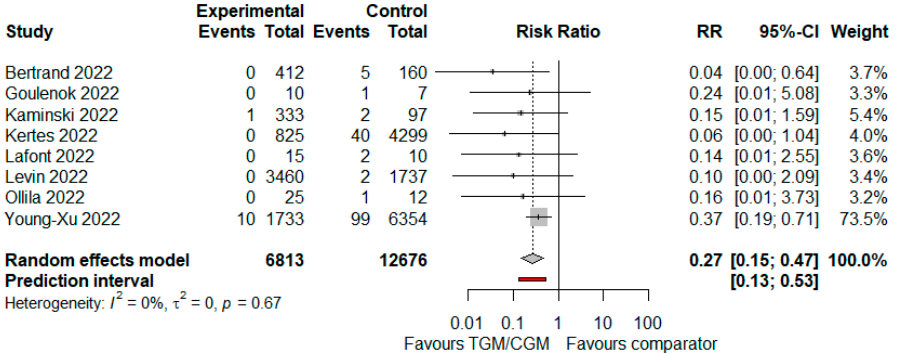
Figure 8. Rate of mortality (TGM/CGM vs. comparator). CI, confidence interval; RR, risk ratio; TGM/CGM, tixagevimab/cilgavimab.